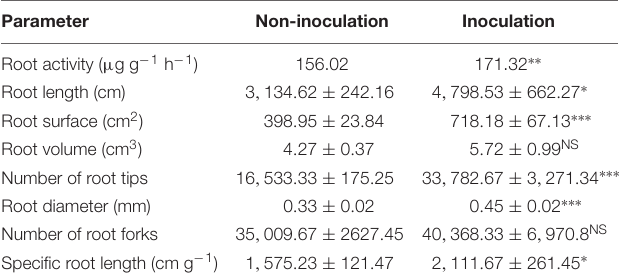
TABLE 1 | Root activity and morphological parameters of Robinia pseudoacacia seedlings inoculated with or without Funneliformis mosseae and grown under the control Pb treatment (0 mg Pb kg − 1 soil) for 4 months.